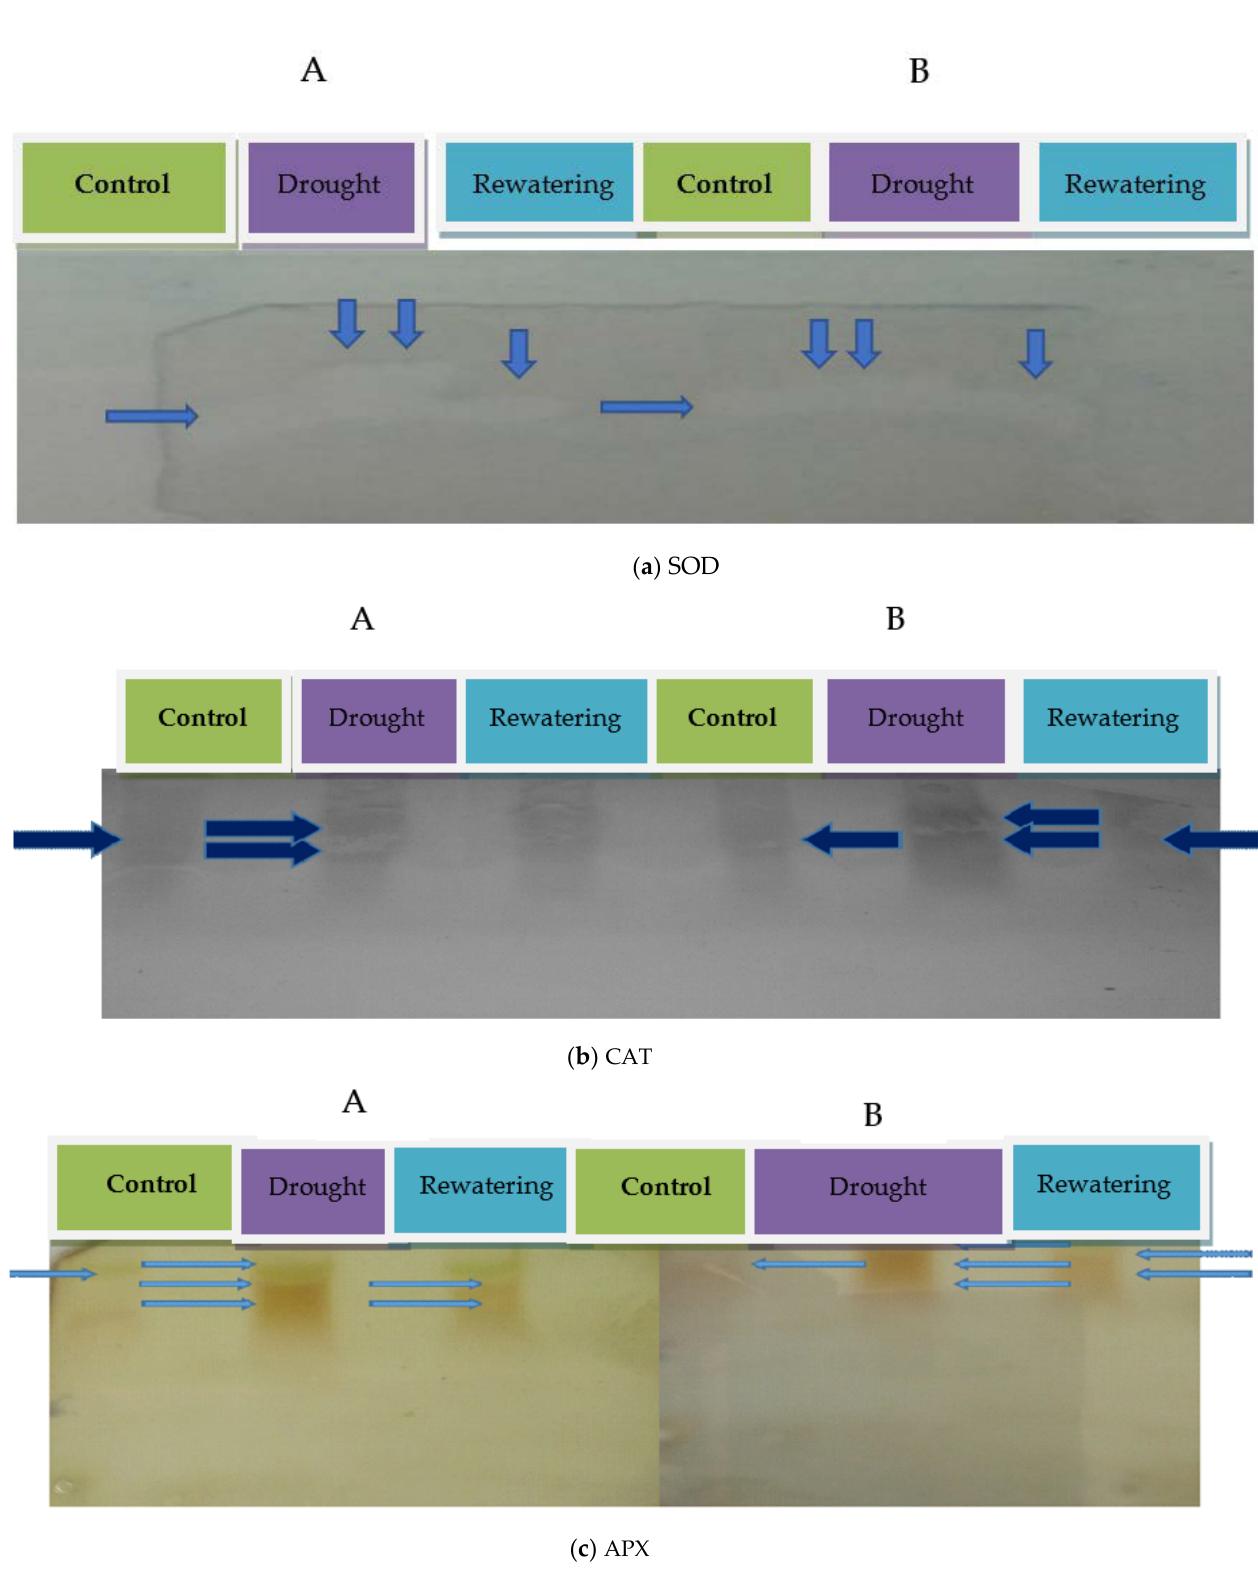
Figure 1. Antioxidant enzyme activities (μmol/g) of SOD ( a ), APX ( b ), and CAT ( c ) in tomato genotypes under irrigated and drought conditions. Values are the means of three replicates with standard deviations. Different bar letters show significant differences among treatments separately.